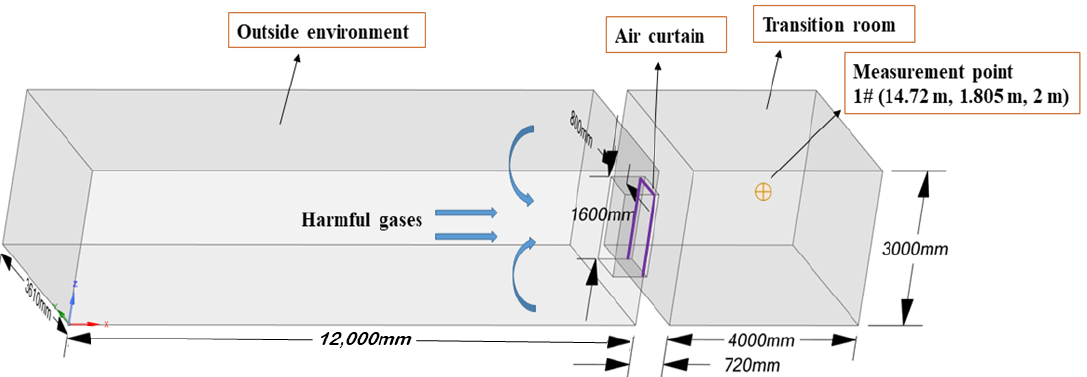
Figure 3. Geometric model of the mine refuge chamber.